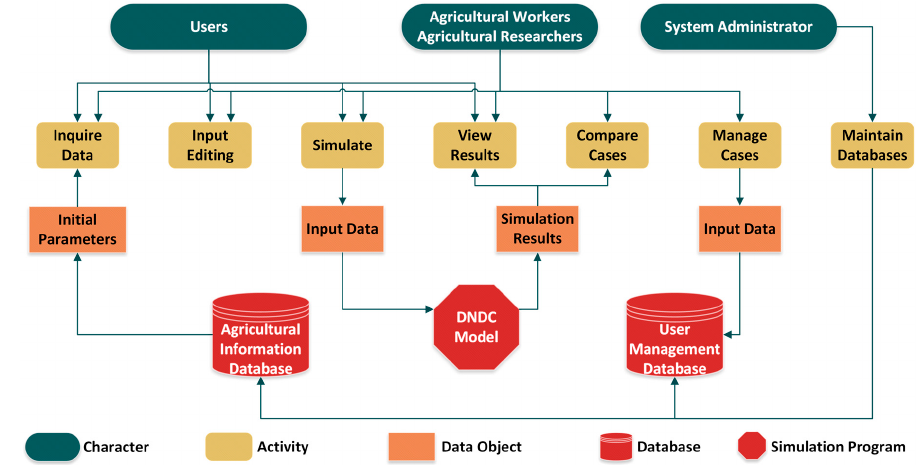
Figure 1. The logical structure diagram of the DNDC online model platform.